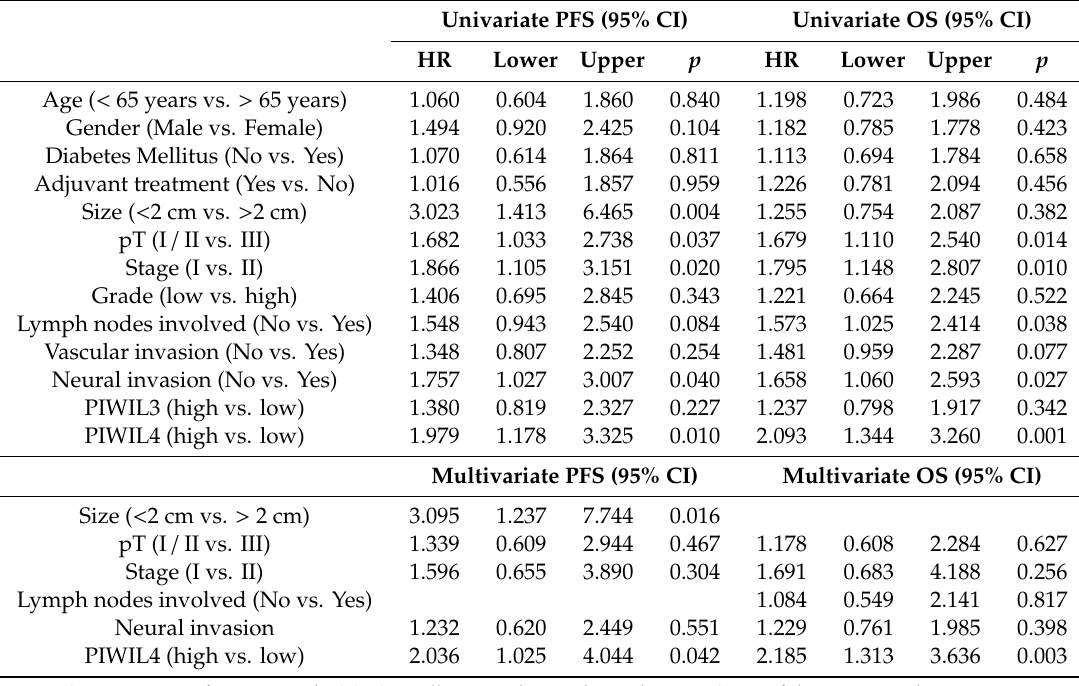
Table 3. Uni- and multivariate proportional hazards model for progression-free and overall survival of patients from the validation